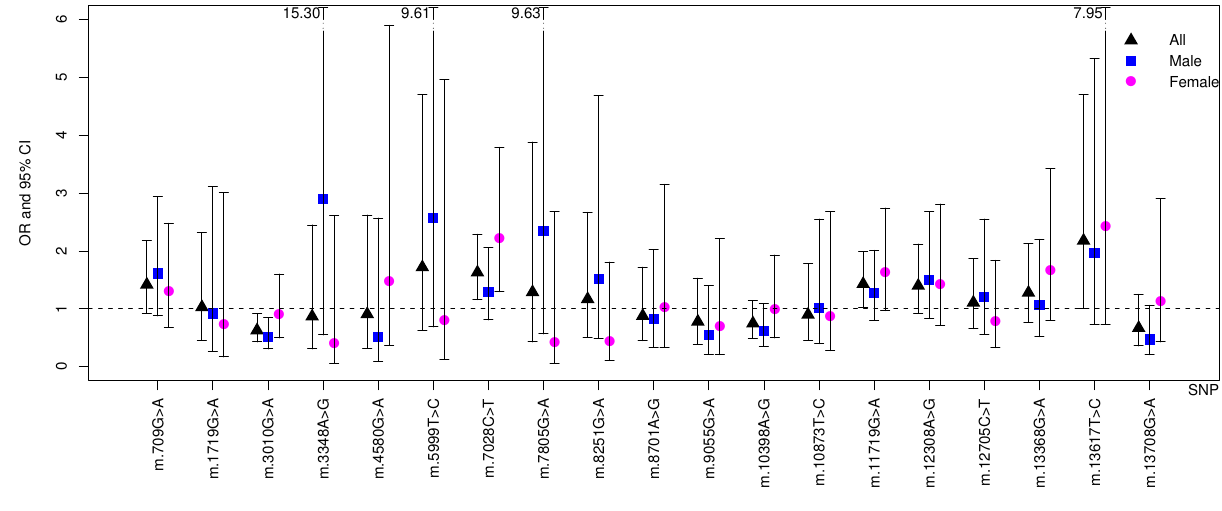
Figure 3 Logistic regression odds ratios and confidence intervals (CIs) for mtDNA SNPs association with ischemic stroke risk . Bars indicate 95% CIs and are shown as dotted lines when the upper confidence limit (CL) is over 6. The upper CL is indicated when it is greater than